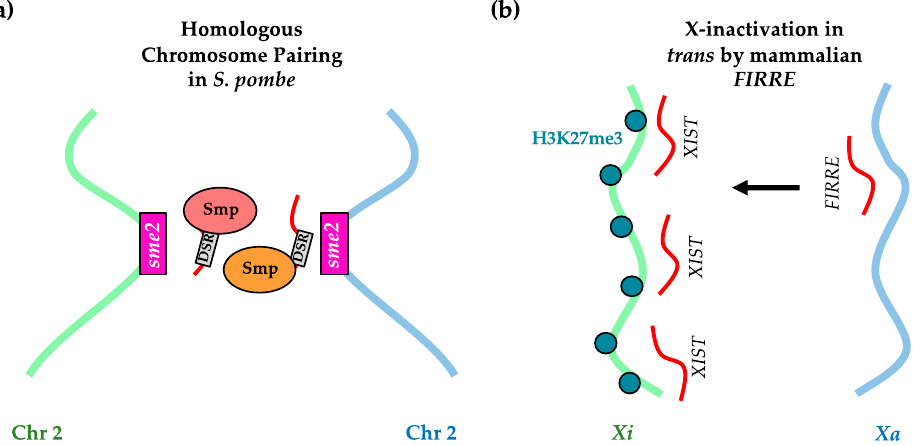
Figure 3 . Intra-chromosomal regulation by long RNAs. ( a ) In S. pombe , DSR motif-containing RNAs from homologous chromosomes recruit sme2 -assocating proteins (SMPs) to form nuclear clusters that help to bring the homologous chromosomes together. ( b ) In mammalian cells, the architectural lncRNA FIRRE that is expressed from the active X chromosome ( Xa ) promotes H3K27me3 and trans inactivation of the X chromosome ( Xi ).